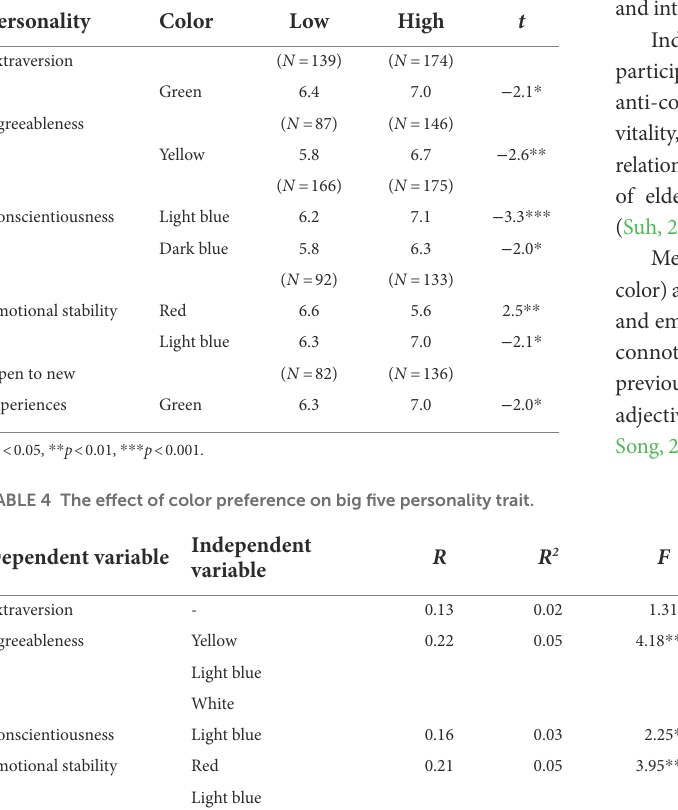
TABLE 3 Comparison between the two personality type groups.